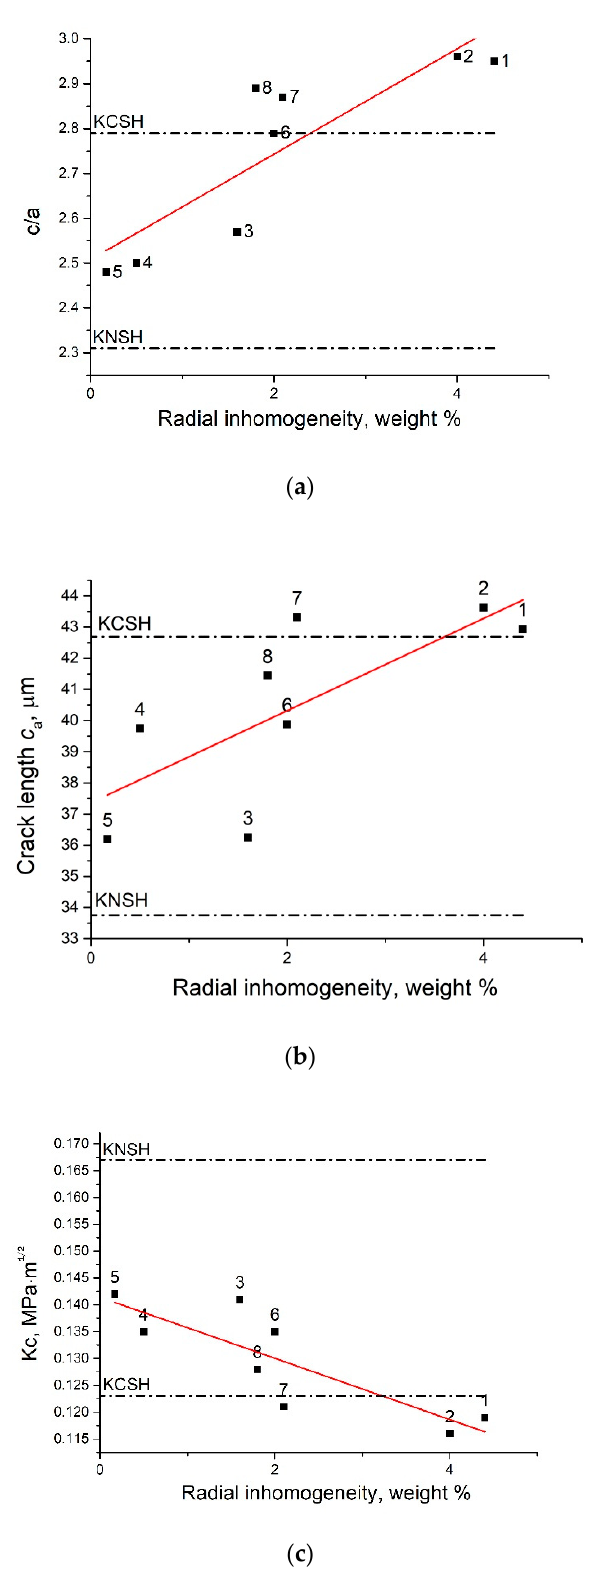
Figure 3. The dependences of parameters c / a ( a ), c a ( b ), and K c ( c ) on the value of the radial inhomogeneity of the KCNSH crystal.